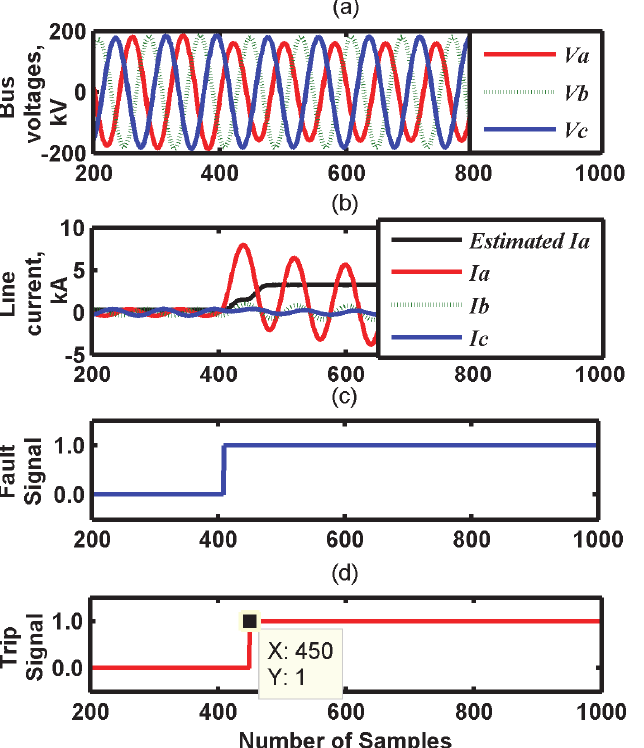
Fig. 9. (a) Bus voltages, (b) line currents and estimated value of fault current, (c) fault signal, and (d) trip signal during L-G fault applied at 50 km at 0.1 s with R F = 0.01 Ω and FIA = 0°.